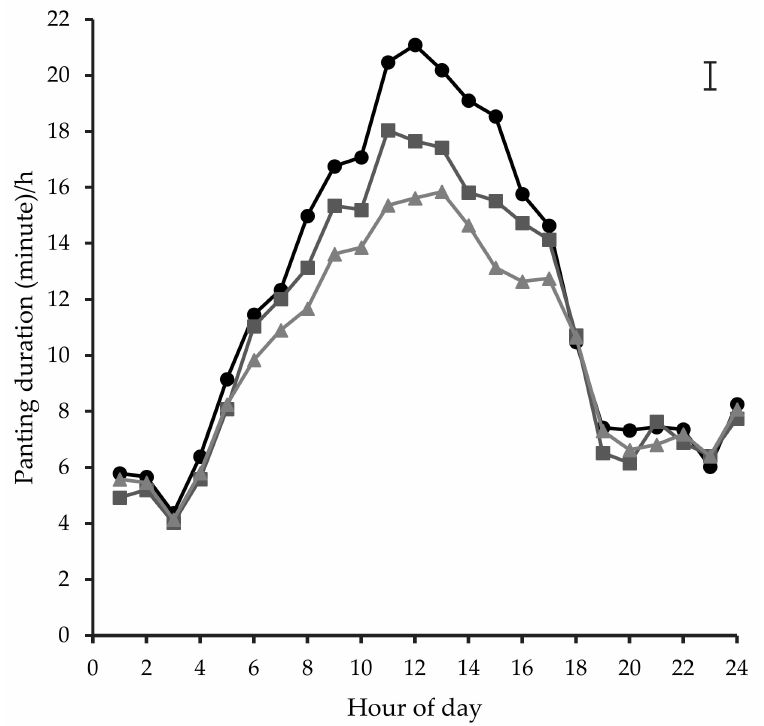
Figure 7. Mean hourly panting duration for cattle of dark ( ), tan ( ), and white ( ) coat colours within the day. The error bar in the right hand top corner denotes average